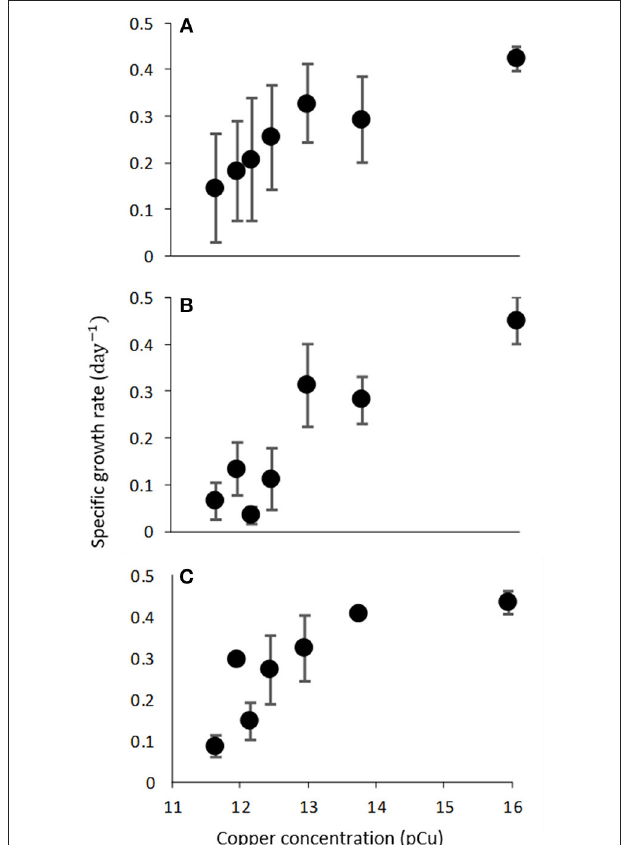
FIGURE 2 | Growth rate (d − 1 ) of C. watsonii WH0003 (A) , WH0005 (B) , and WH0402 (C) as a function of increasing pCu. Points represent averages of triplicate treatments ± standard